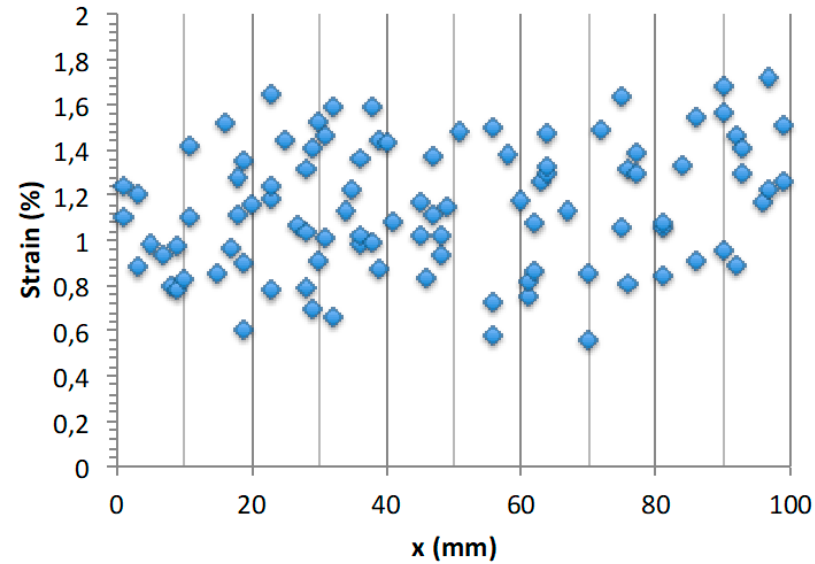
Figure 15. Linear distribution ε ( x ) of flaw strengths along tow axis.